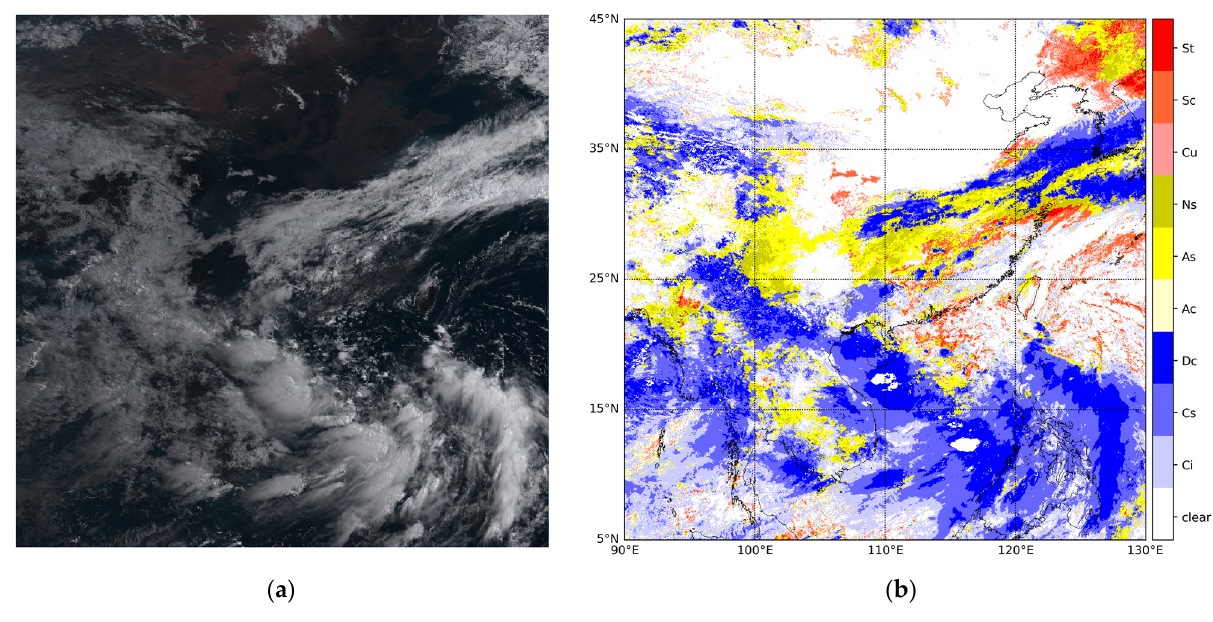
Figure 2. ( a ) The Himawari-8 satellite observation image; ( b )The Himawari-8 satellite cloud-type product.